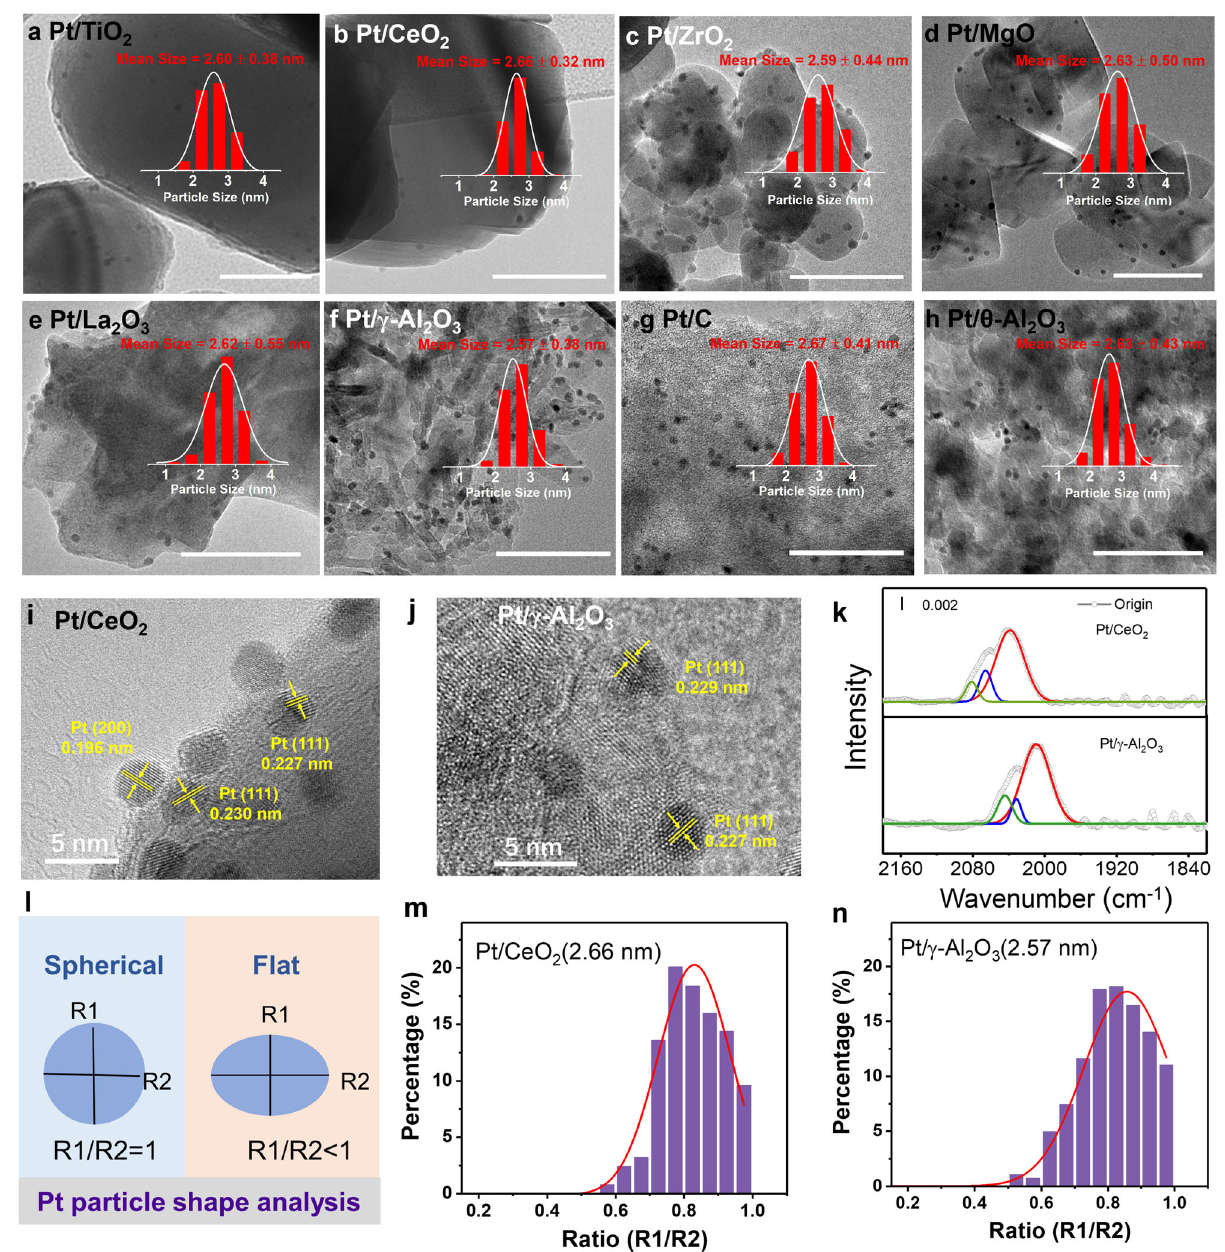
Fig. 1 Morphology characterization of Pt-based catalysts. a – h HRTEM images of the size-controlled Pt catalysts over different supports and the inset are their size distribution histograms; scale bar: 50 nm. Representative HRTEM images of as-synthesized catalysts: Pt/CeO 2 ( i ), Pt/ γ -Al 2 O 3 ( j ), and its corresponding infrared spectroscopy of CO adsorption ( k ). l Schematic presentation of the particle shape analysis based on the TEM images. The frequencies of Pt NPs diameter ratio distributions R1/R2 over CeO 2 ( m ) and γ -Al 2 O 3 ( n